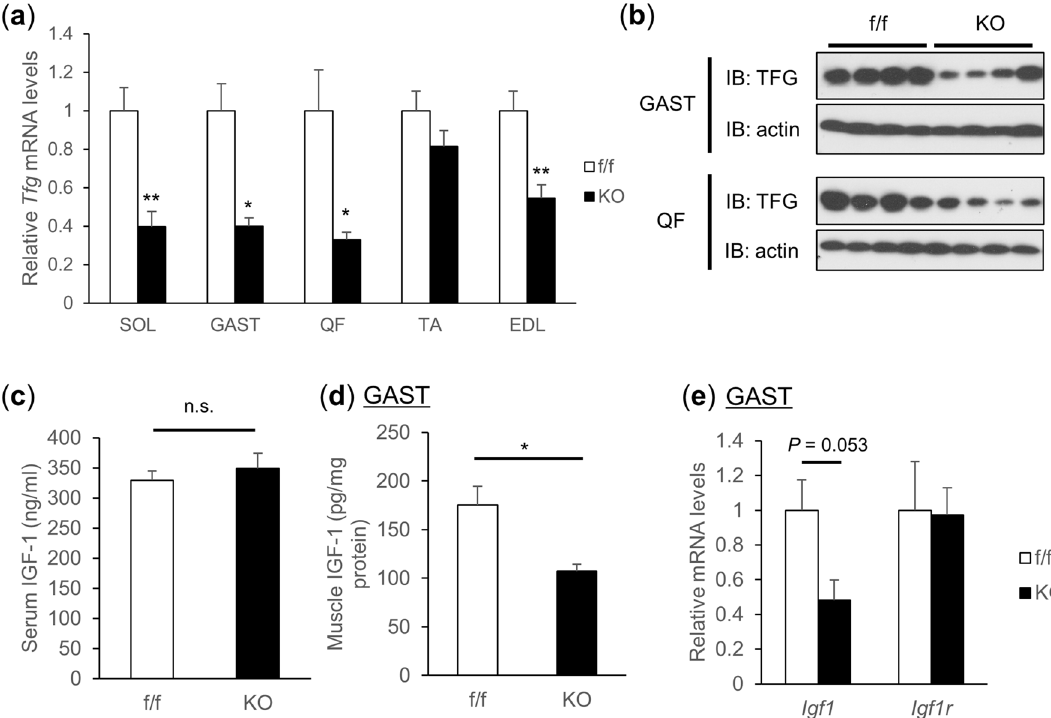
Figure 4. TFG is downregulated in muscles from vMNTFG KO mice. ( a ) Relative Tfg mRNA levels in each muscle (6-month-old, n = 5). ( b ) Western blotting of gastrocnemius (GAST) and quadriceps femoris (QF) muscle samples (6-month-old mice). ( c ) Serum IGF-1 concentrations (8-month-old mice, n = 5). ( d ) IGF-1 concentrations in GAST homogenates (8-month-old mice, n = 5, adjusted by the protein concentration). ( e ) Relative Igf1 and Igf1r mRNA levels in GAST (6-month-old mice, n = 4–5). (* P < 0.05, ** P <